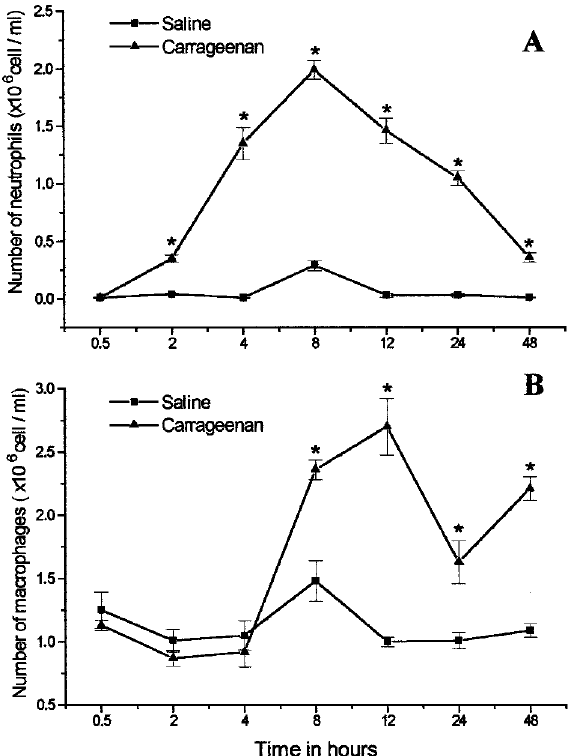
FIG. 1. Kinetic of leukocyte influx to peritoneal cavity of mice after i.p. injection of a carrageenan (Cg) solution (300 m g/0,2ml per animal). Number of neutrophils in the peritoneal cavity after the irritant injection (A). Number of mononuclear cells after Cg injection (B). The results are expresses in absolute numbers obtained in relation to the total number of collected cells. Data represent mean values ±S.E.M. for 8–16 animals for each experimental time. *Significantly different from mean values of saline group ( p <